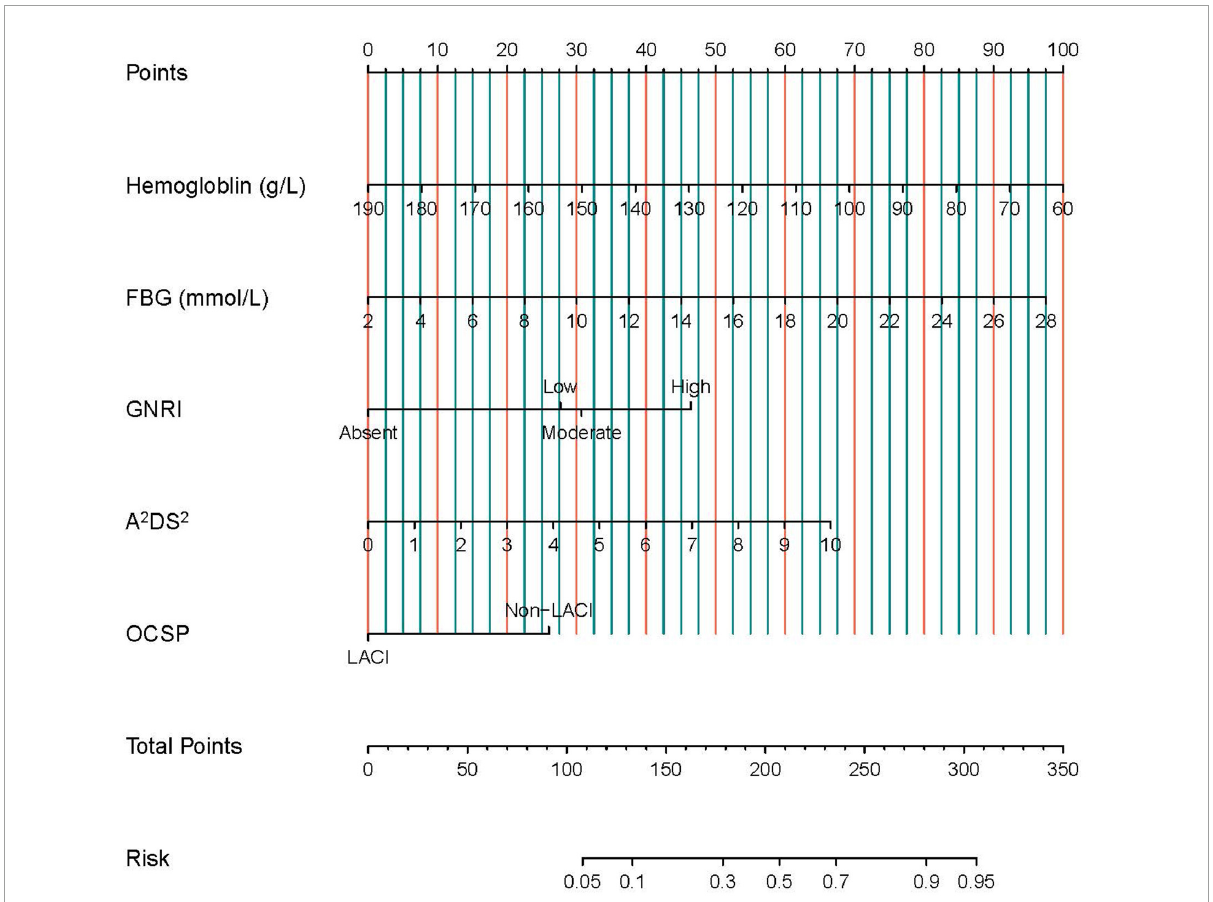
FIGURE3 The nomogram for predicting the occurrence of SAP in AIS patients with T2DM. Each risk factor is given a point based on the nomogram. The total points are calculated by summing up the corresponding scores on the points scales of each variable. The probability of SAP can be obtained by locating the total points on the “Total Points” axis and drawing a vertical line down to the “SAP Risk” axis. SAP, stroke-associated pneumonia; GNRI, Geriatric Nutritional Risk Index; OCSP, Oxfordshire Community Stroke Project; LACI, lacunar circulation infarction; FBG, fast blood